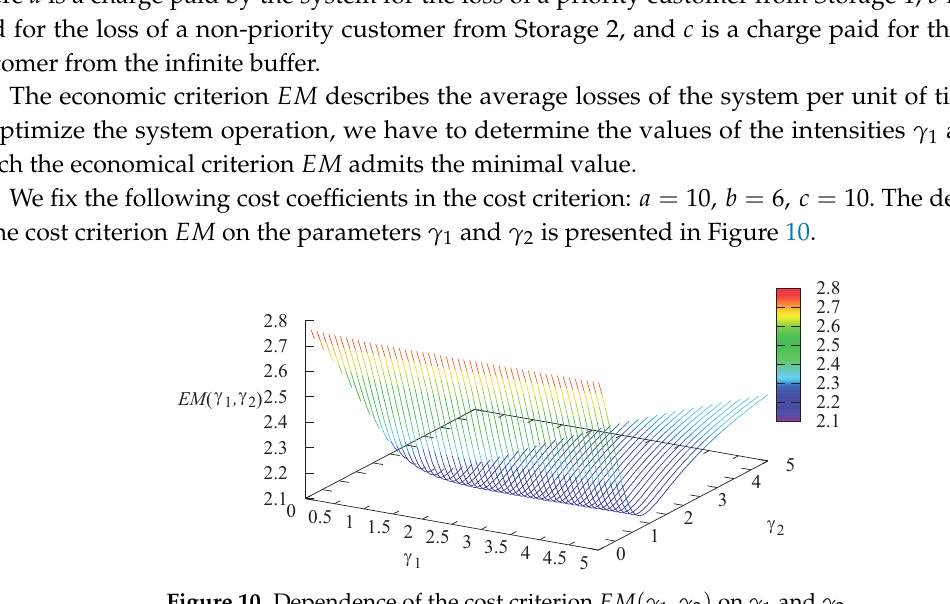
Figure 10. Dependence of the cost criterion EM ( γ 1 , γ 2 ) on γ 1 and γ 2